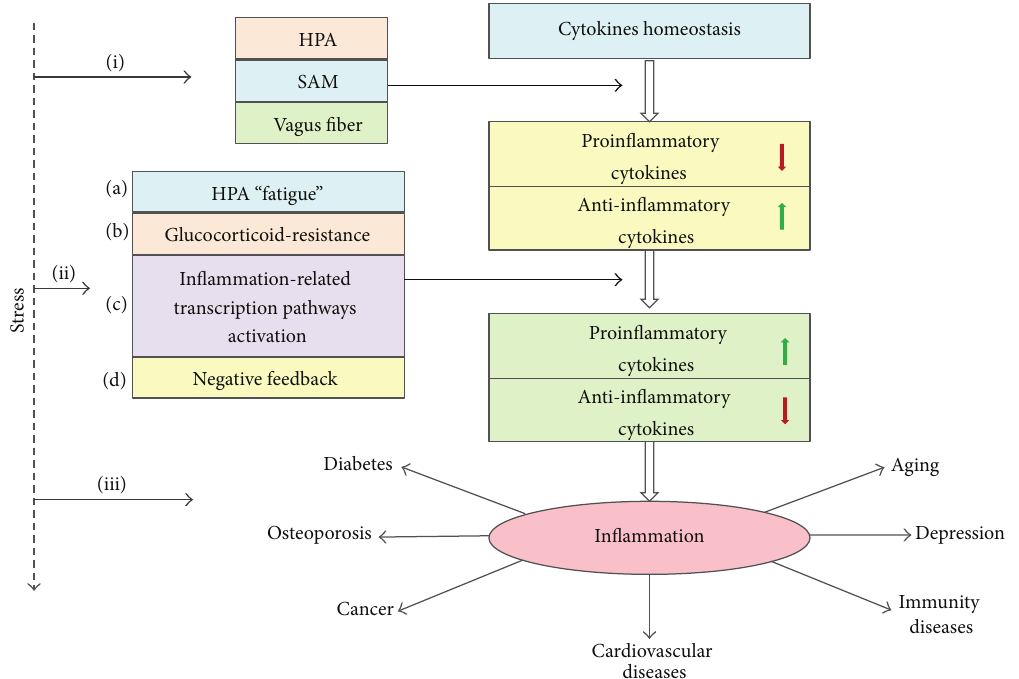
Figure 2: The possible change process of inflammatory cytokines in the chronic stress. (i) The chronic stressor disturbs the cytokines homeostasis through activating HPA axis, SAM axis, and vagus fiber, and they, respectively, promote the secretions of GCs, CAs, and Ach to suppress the proinflammatory cytokines secretion while promoting the anti-inflammatory cytokines secretion. (ii) Sustained stressor exposurechangestoupregulatetheproinflammatorycytokinesanddownregulatetheanti-inflammatorycytokinesthroughthefollowingfour pathways: (a) HPA “fatigue”; (b) glucocorticoid-resistance; (c) the inflammation-related transcription pathways (NF- 𝜅 B, AP-1, JAK-STAT, MAPKs) activation; and (d) organism negative feedback. (iii) The lasting chronic stress further increases the proinflammatory cytokines, which induces inflammatory response and may ultimately cause various